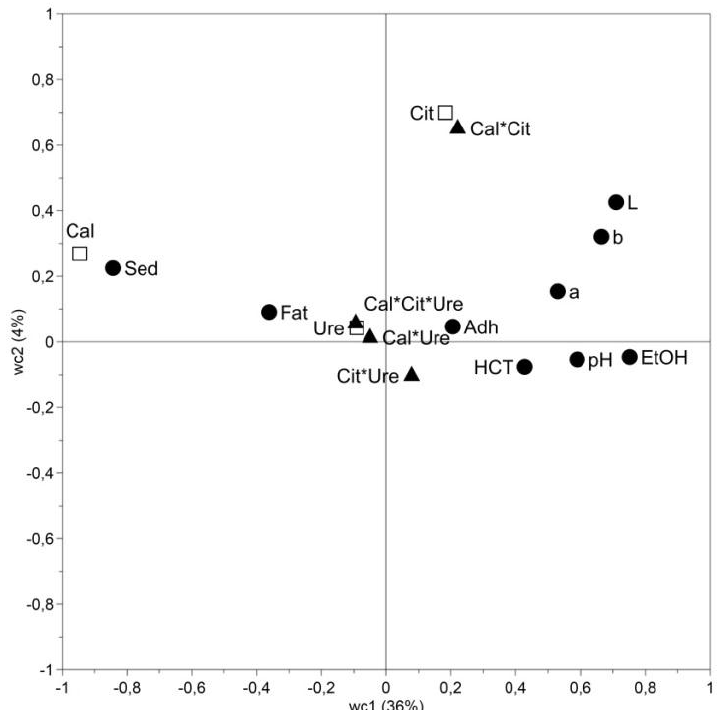
Figure 1. Partial least squares (PLS) for ultra-high temperature treated milk stored for 0-52 weeks at 4, 20, 30, and 37 °C. (□) factors, ( ▲ ) interaction terms, and (●) responses. The systematic variation in the data is to 36% and 4%, explained by the first and second principal components, respectively.